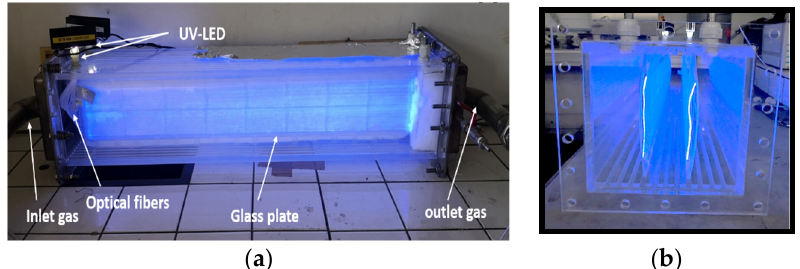
Figure 3. ( a ) Images of a photocatalytic reactor based on optical fibers, ( b ) of a side view (Range of processed flow: from 5 at 20 m 3 /h with concentrations varying from 5 to 50 mg/m 3 )) [5].